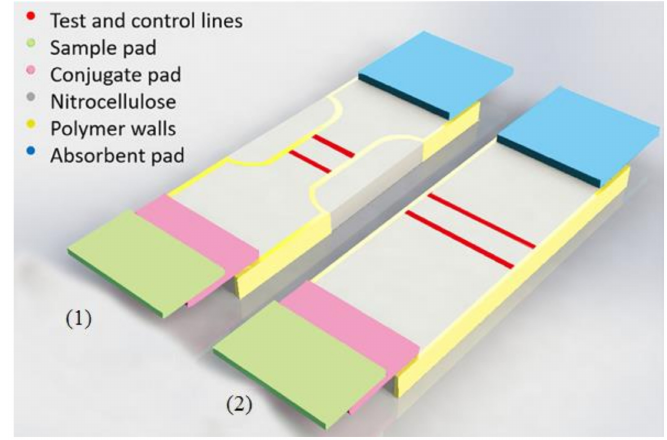
Figure 21. Schematic of a lateral flow device with and without polymer sidewalls